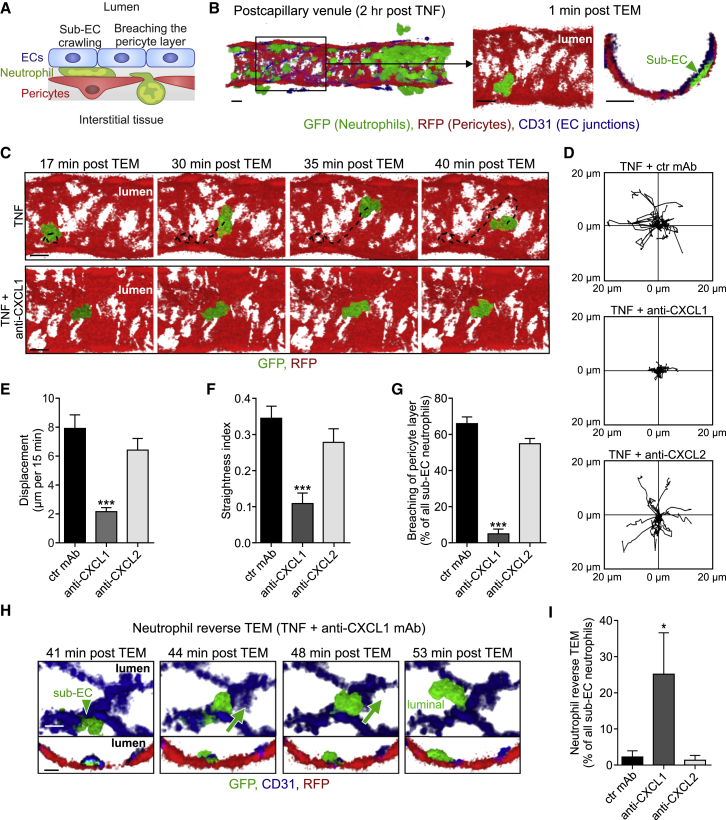
Neutrophil-Pericyte Interactions Are Selectively Mediated by Endogenous CXCL1Lyz2-EGFP-ki;Acta2-RFPcherry-Tg mice, subjected to in vivo CD31 labeling, were stimulated locally with TNF and 100 min later i.s. injected with ctr or blocking mAbs, as indicated.(A) Neutrophil responses quantified in cremasteric venules by confocal IVM in (C)–(G).(B) Representative confocal IVM luminal and cross-sectional views depicting a neutrophil localized between TNF-stimulated ECs and pericytes 1 min post TEM.(C) Time-lapse IVM images (Video S3) showing a neutrophil crawling on pericytes (tracks, dashed lines) in a TNF-stimulated tissue (top) and the inhibition of this response in tissues treated with anti-CXCL1 mAb (bottom).Scale bars in (B) and (C), 10 μm.(D–G) Crawling profiles of neutrophils on pericytes (20 cells per group for clarity) (D) as normalized for their origin and associated quantifications of displacement (E), straightness index (displacement/track length) (F), and breaching of the pericyte layer (G).(H) Time-lapse confocal IVM images (Video S4) illustrating neutrophil reverse TEM in a tissue treated with TNF+anti-CXCL1 mAb (luminal and cross-sectional views; scale bars, 5 μm).(I) Quantifications of neutrophil reverse TEM. Images are representative of 5–10 independent experiments and quantifications (n = 5–10 mice per group) involve 20 independent experiments.